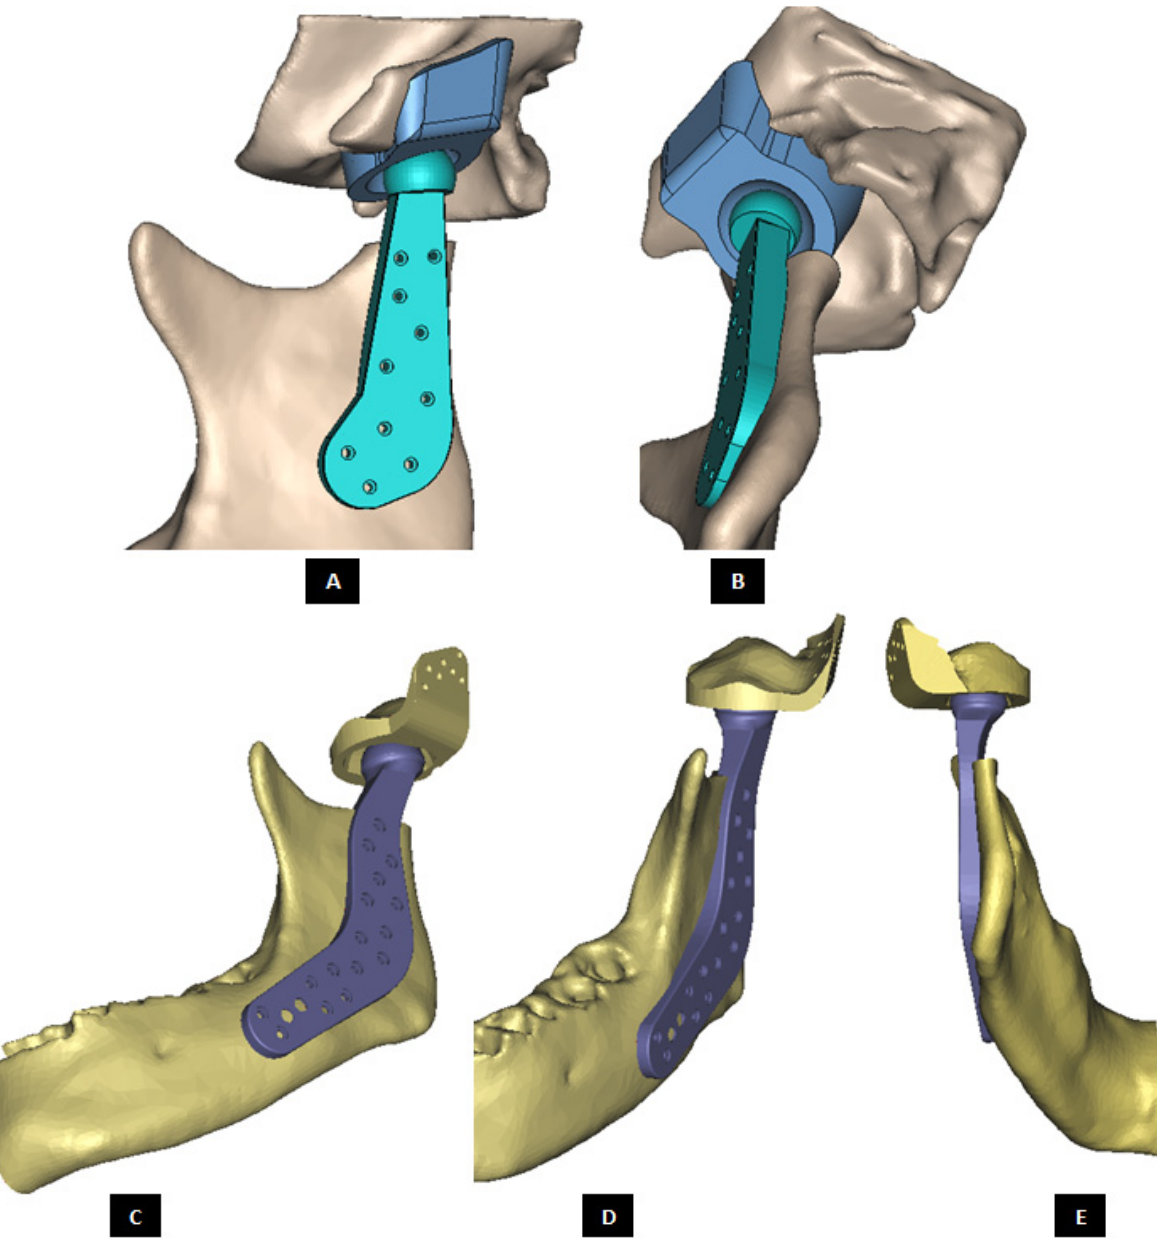
Figure 21. Patient-specific total TMJ prostheses with different articulations and fixation ( A – E